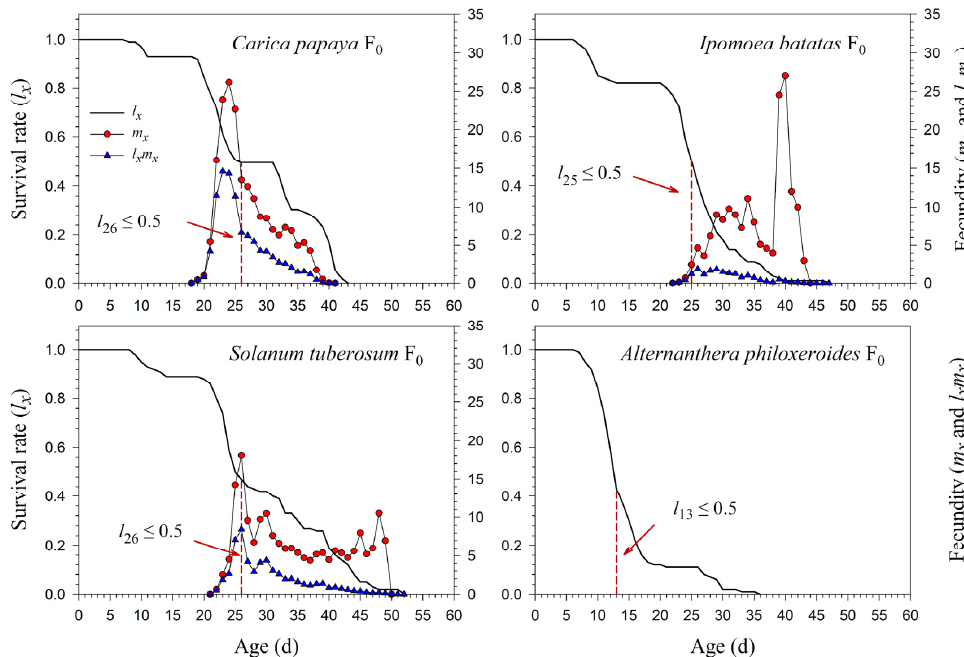
Figure 3. Age-specific survival ( l x ), fecundity ( m x ), and net maternity ( l x m x ) rates of Paracoccus marginatus individuals reared on four different host plants (F 0 ). The red vertical dashed lines in the figure denote the age at which the survival rate l x ≤ 0.5.